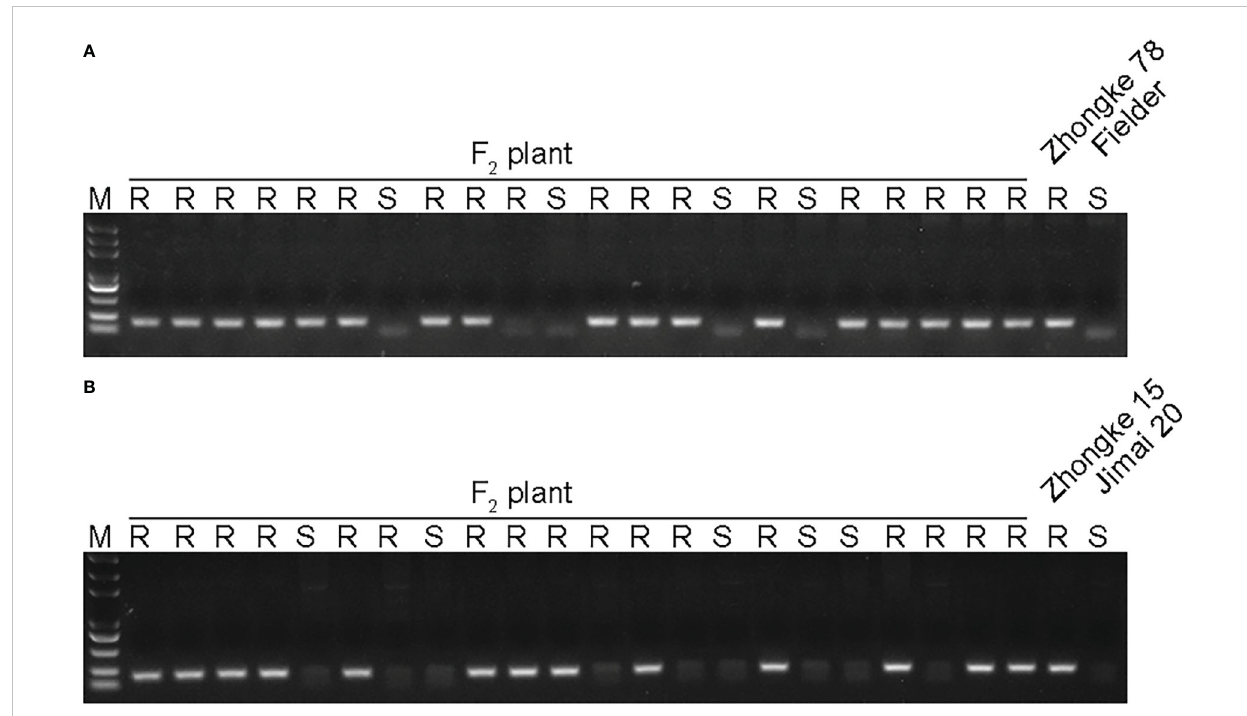
FIGURE 5 Detecting the alien chromatins among F 2 plants derived from Zhongke 78/Field and Zhongke 15/Jimai 20 by using the speci fi c marker T14K50. (A) Detecting the alien chromatin among F 2 plants derived from the cross of Zhongke 78 and Fielder. (B) Detecting the alien chromatin among F 2 plants derived from the cross of Zhongke 15 and Jimai 20. M, DNA marker. R, resistance to stripe rust. S, susceptible to stripe rust.